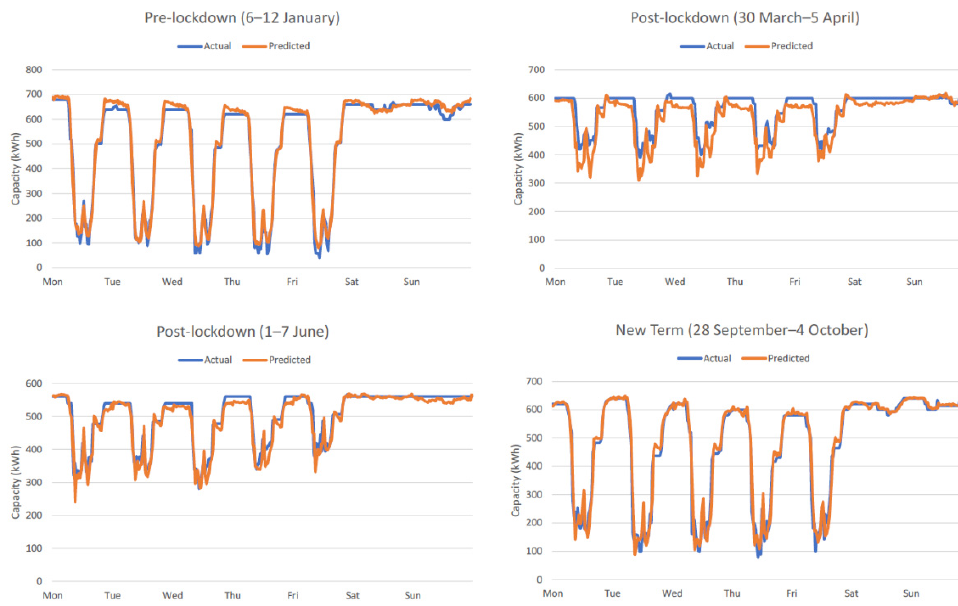
Figure 10. Actual vs. predicted capacity using the online machine learning model for 4 sample weeks during 2020.